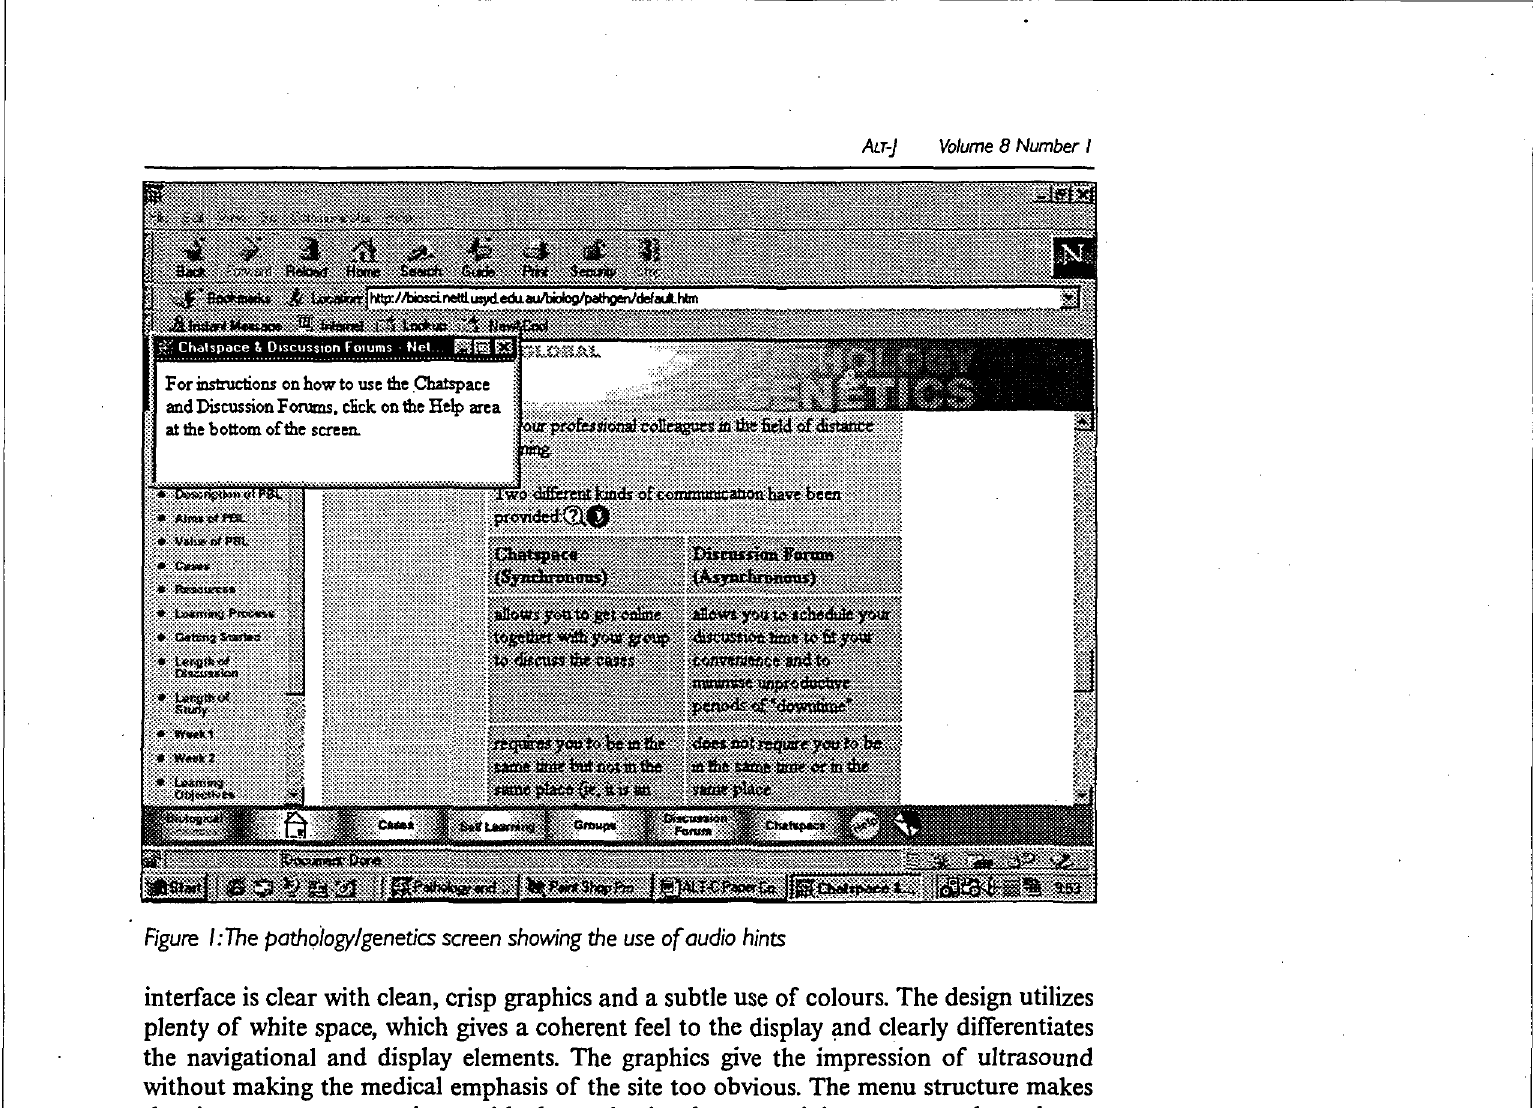
figure /;77ie patholog/Zgenetics screen showing the use of audio